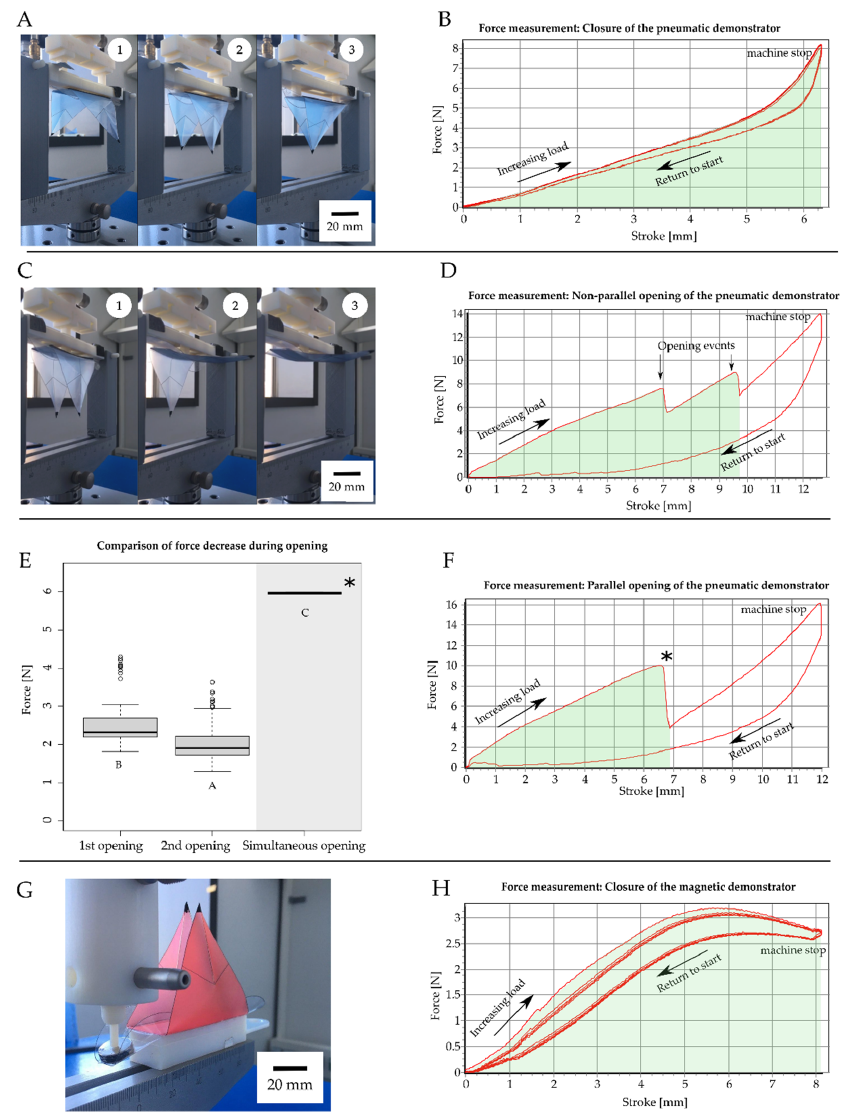
Figure 8. Kinematic energy measurements: examples of force displacement measurements carried out on the pneumatic and magnetic VFfs. Force measurements are used to calculate the energy needed to close and open the system. To imitate the closure of the pneumatic demonstrator, a piston with two pins is used to apply pressure to the backbone until the lobes close ( A1 – A3 ). The force ( B ) necessary to close the lobes is measured repeatedly. The force for the opening movement is measured with a piston designed to apply pressure at the center of the backbone ( C1 – C3 ). In most cases, the lobes open one after another ( C2 , C3 ) resulting in two distinct sudden drops in the force measured ( D ). When both lobes open simultaneously ( F ), the measured decrease in force (indicated by * in ( E , F )) is larger compared with the separate opening events ( E ). Each of the three demonstrators used for video analysis were tested 25 times for opening and closing movements, respectively. The magnetic demonstrator ( G , H ) needed less force compared with the pneumatic demonstrator and also less energy. The force-displacement curves shown in ( B , D – F , H ) represent exemplary curves. Significance levels are indicated by the capital letters next to each boxplot. Different letters represent significant differences from other results with p -values below 0.05 ( B